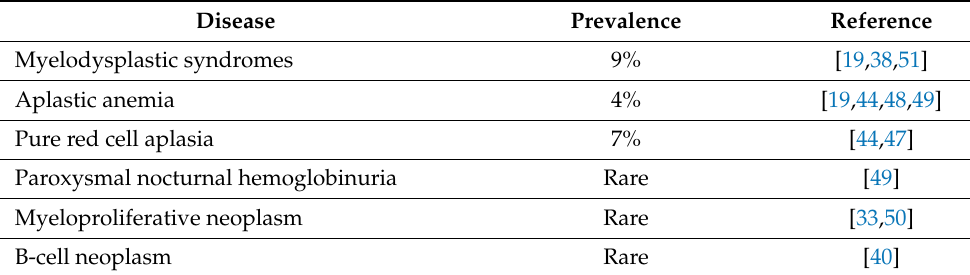
Table 3. Hematological disease associated with LGL